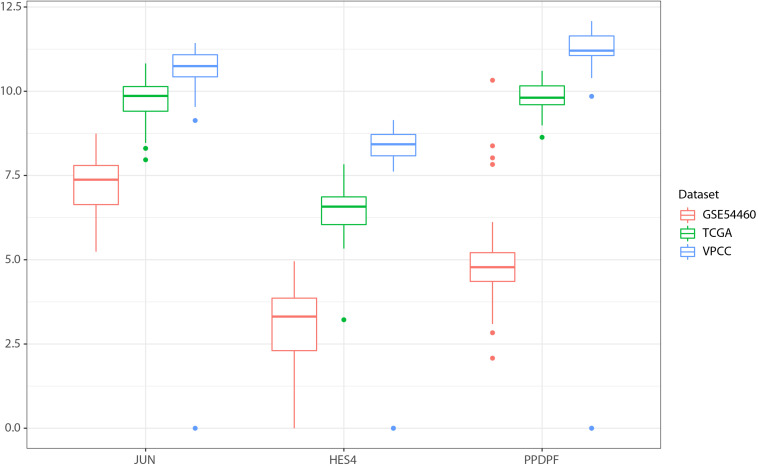
Log2 transformed distribution of normalized read counts for the three genes signature in each cohort.